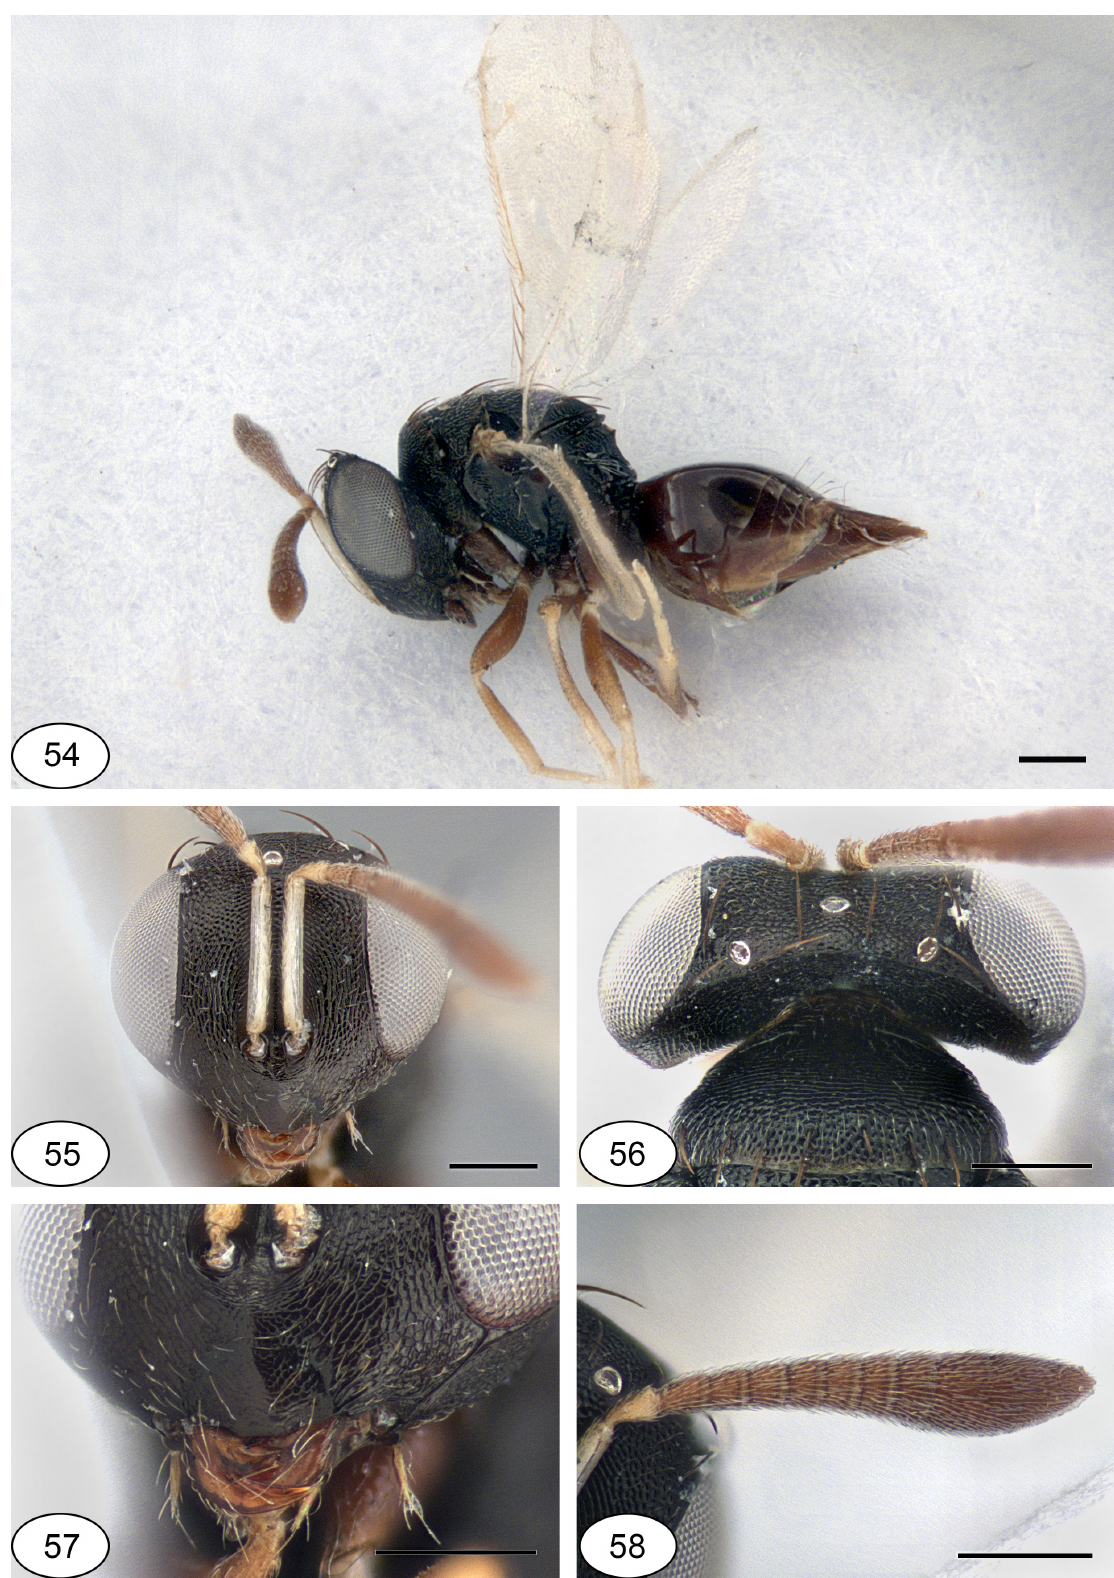
Figs 54–58. Netomocera desaegeri sp. nov., holotype, ♀ . 54 . Habitus, lateral view. 55 . Head, frontal view. 56 . Head, dorsal view. 57 . Lower face. 58 . Antenna. Scale bars: 0.2